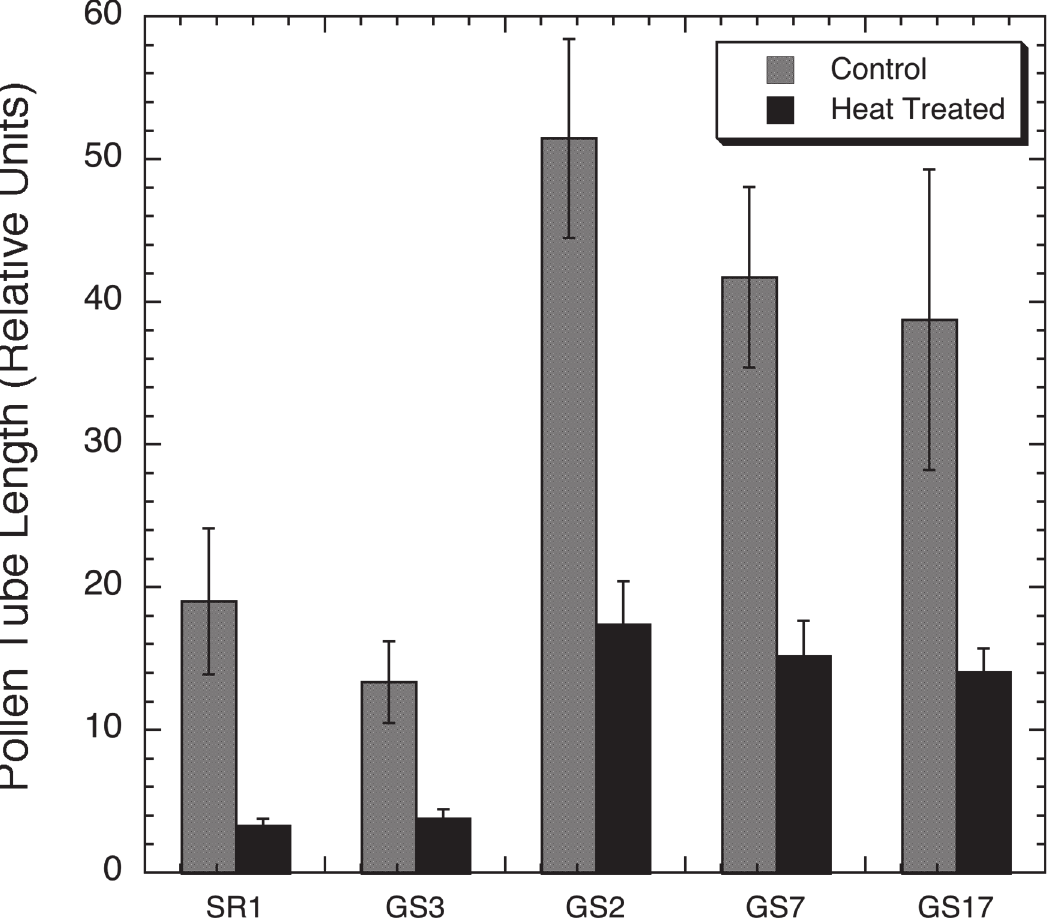
Fig 6. Tobacco pollen germination following a high temperature challenge. Graph comparing the relative pollen tube lengths of SR1, SR1-GS3, SR1-GS2, SR1-GS7, and SR1-GS17 tobacco pollen following a 60-min incubation at 30°C (control — white bars) or 7 min at 50°C followed by 53 min at 30°C (heat treated — black bars).